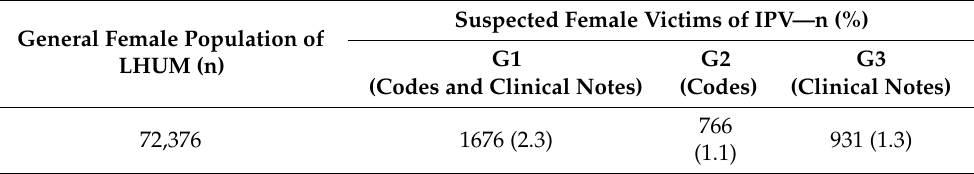
Table 1. Female population observed at LHUM,